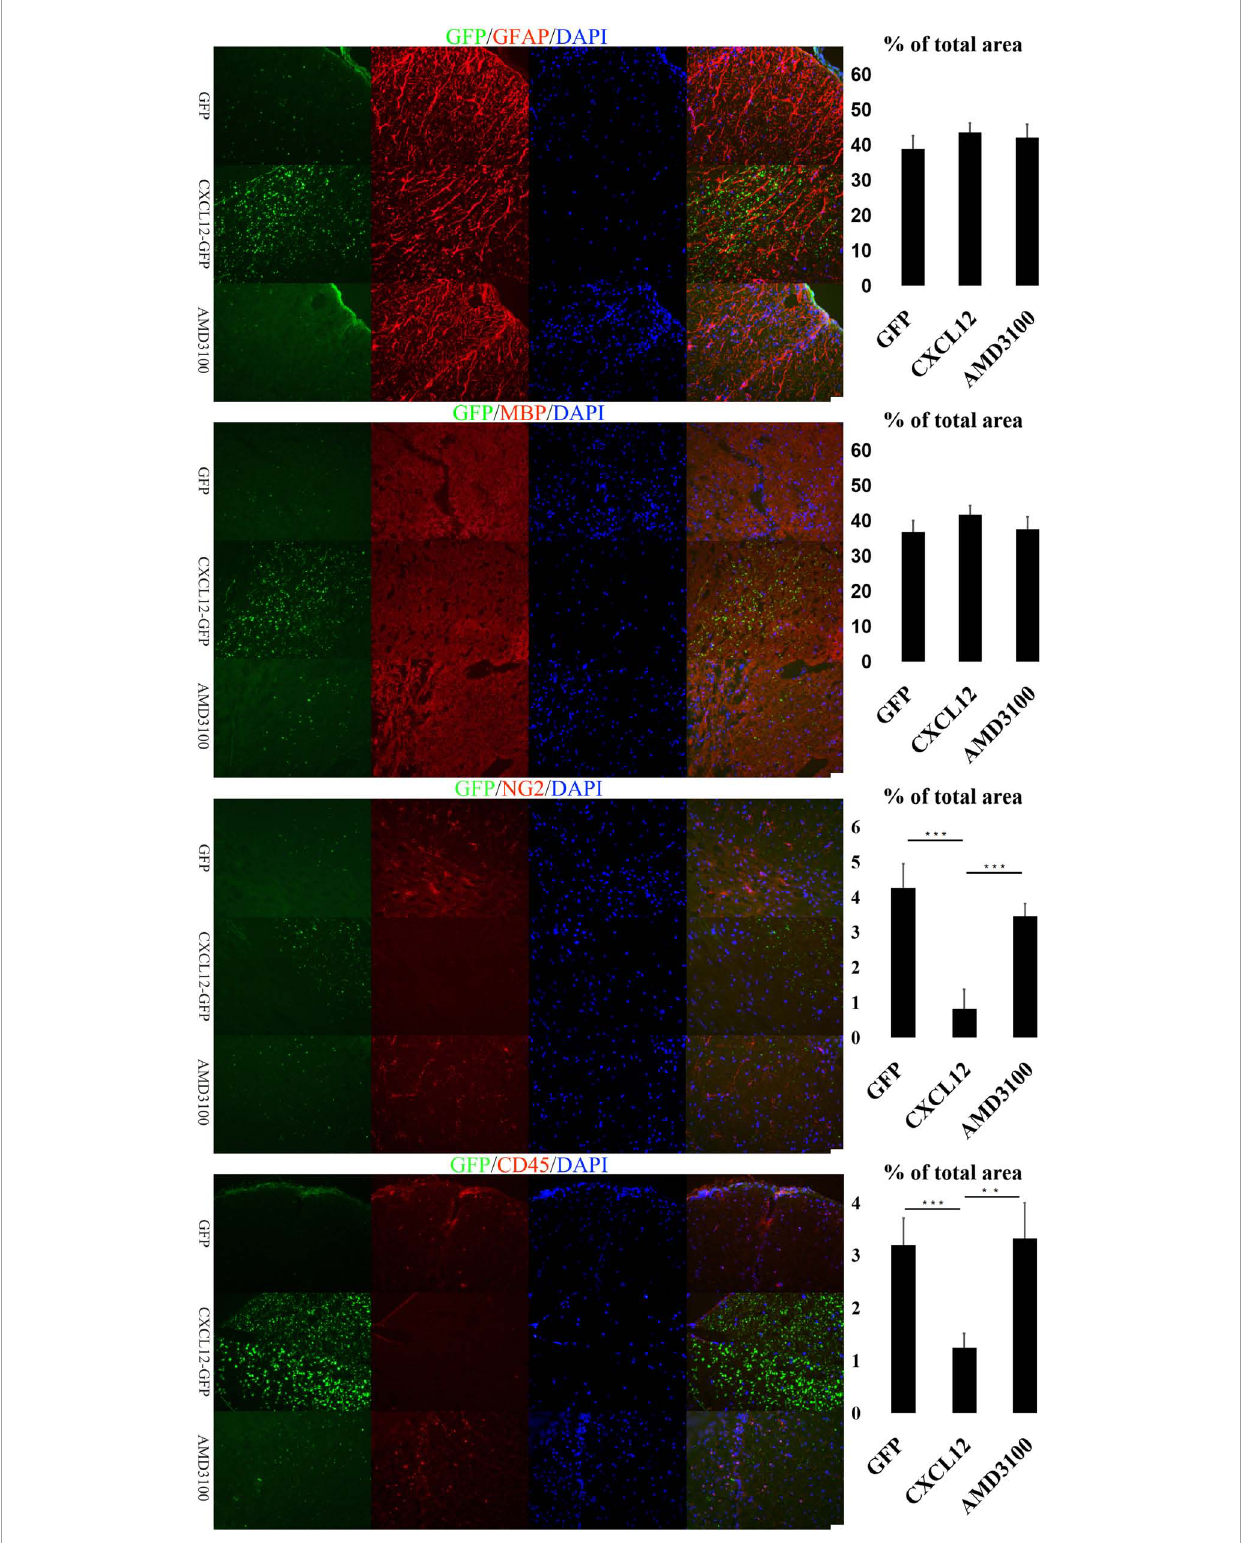
FIGURE5 At the recovery stage of experimental autoimmune encephalomyelitis (EAE), upregulation of CXCL12 promoted the remyelination of spinal cord. During the recovery stage of EAE, the glial fibrillary acidic protein (GFAP) and myelin basic protein (MBP) signals indicated that the spinal myelin sheath was restored in the eGFP group and CXCL12 + AMD3100 group, but the infiltration of leukocytes (CD45 +) and the migration of OPCs (NG2 +) were still stronger than those in the CXCL12 group. Data presented as the mean ± SEM. “*” represents value of P < 0.05, “**” represents value of P < 0.01, “***” represents value of P < 0.001 by two-tailed Student’s t -test or one-way ANOVA, n = 4–6 rats. The bar in the lower right represents 50 µ